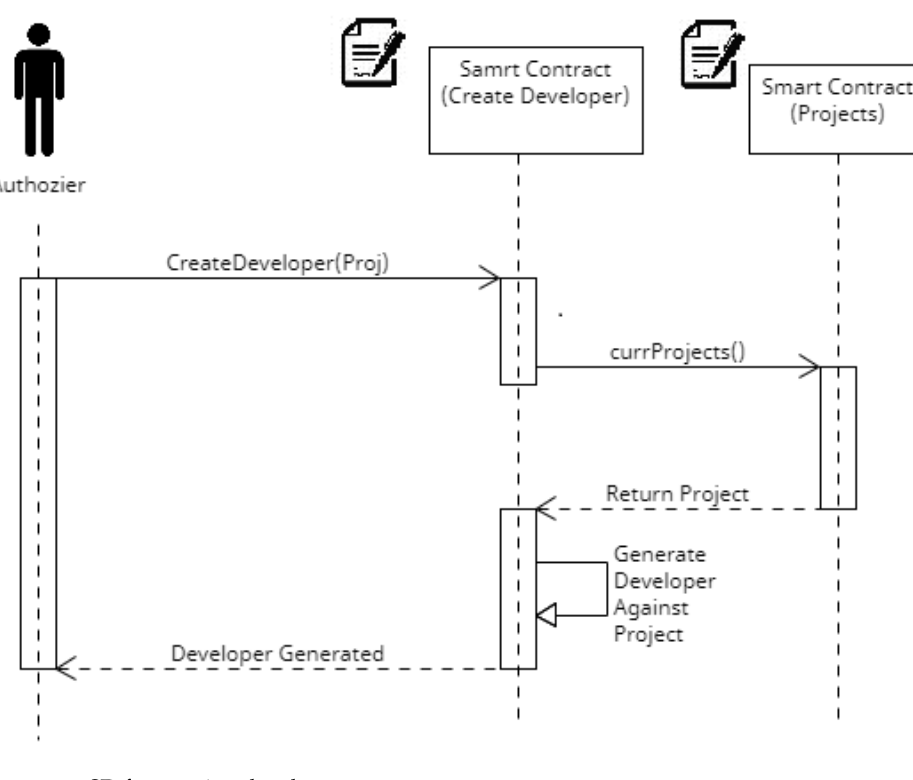
Figure 11. Smart contract for creating a developer.